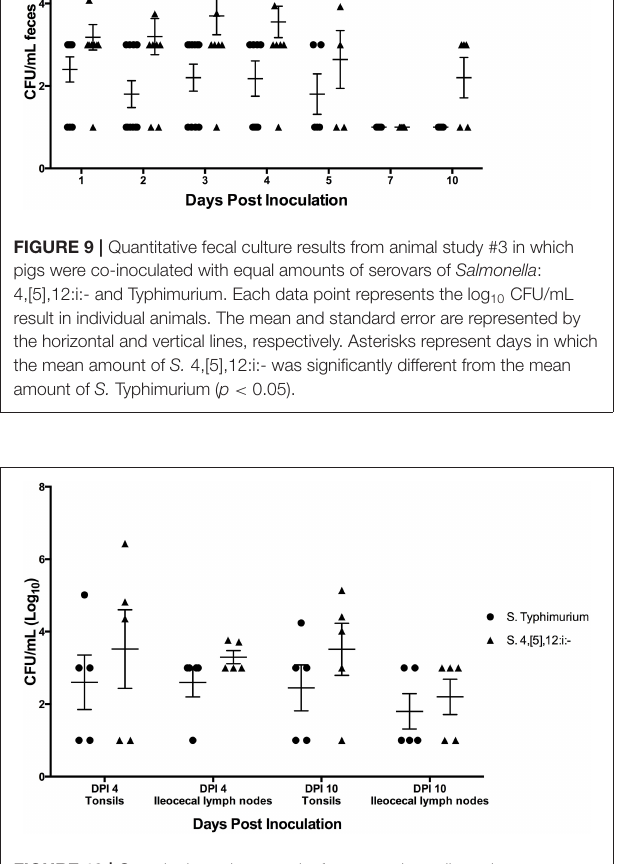
FIGURE 10 | Quantitative culture results from samples collected upon necropsy in animal study #3 in which pigs were simultaneously co-inoculated with equal amounts of two serovars of Salmonella : 4,[5],12:i:- and Typhimurium. Each data point represents the log 10 CFU/mL result in individual animals. The mean and standard error are represented by the horizontal and vertical lines, respectively.